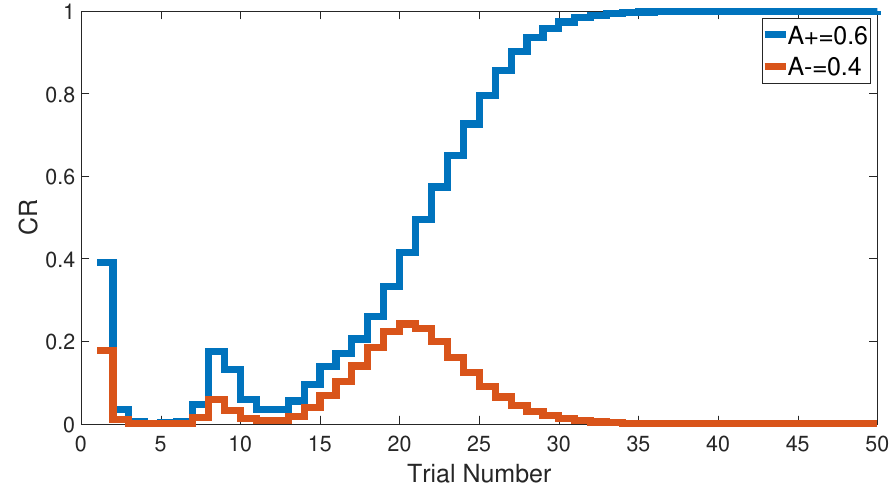
Figure 19. Hard transfer task for the intact system.